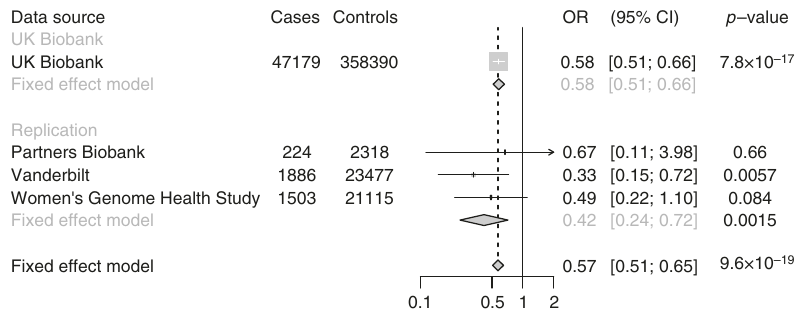
Fig. 2 Association of IL33 c.487-1G> C with asthma in UK Biobank, Partners Biobank, Vanderbilt eMERGE network and Women ’ s Genome Health Study. UK Biobank estimates were derived using logistic regression, adjusted for age, sex, ten principal components of ancestry, and array type. Partners Biobank and Vanderbilt estimates were derived using logistic regression, adjusted for age, sex, and principal components of ancestry. Women ’ s Genome Health Study estimates were derived using logistic regression, adjusted for age and principal components of ancestry